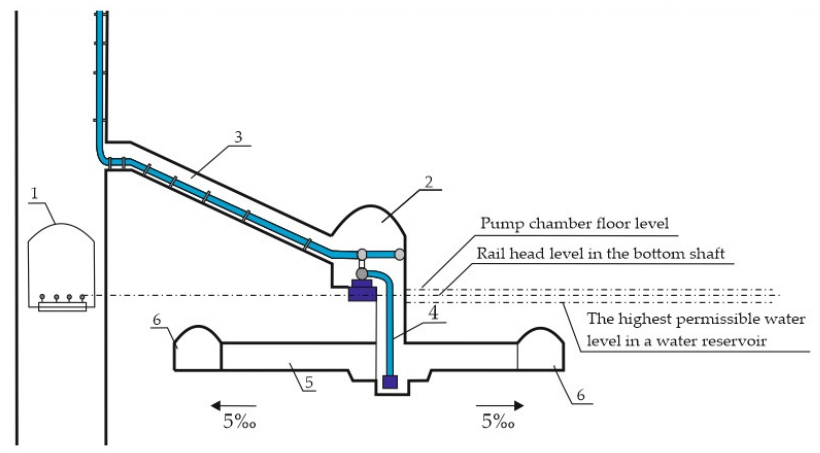
Figure 18. Main drainage workings: 1—bottom shaft; 2—pump chamber; 3—pipe channel; 4—pump suction well; 5—water channels; 6—water reservoirs.